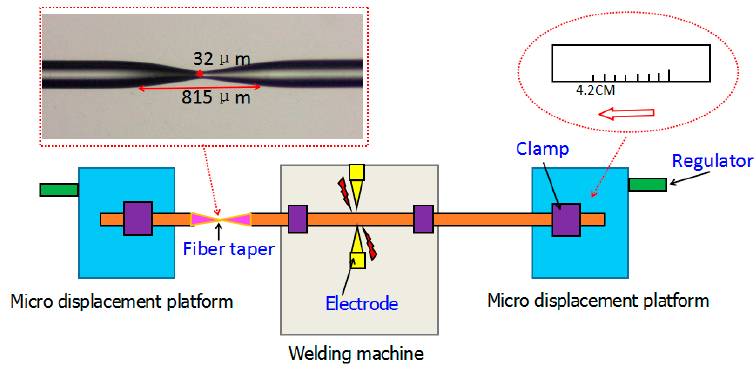
Figure 1. Cascaded symmetrical dual-taper preparation of Mach-Zehnder